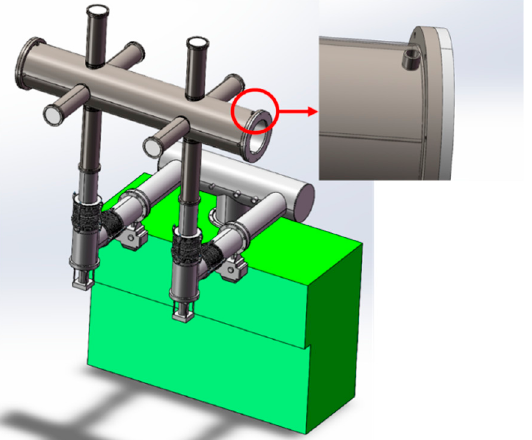
Figure 12. Schematic drawing of the vacuum subsystem. The main vacuum chamber has a water- cooled interlayer.